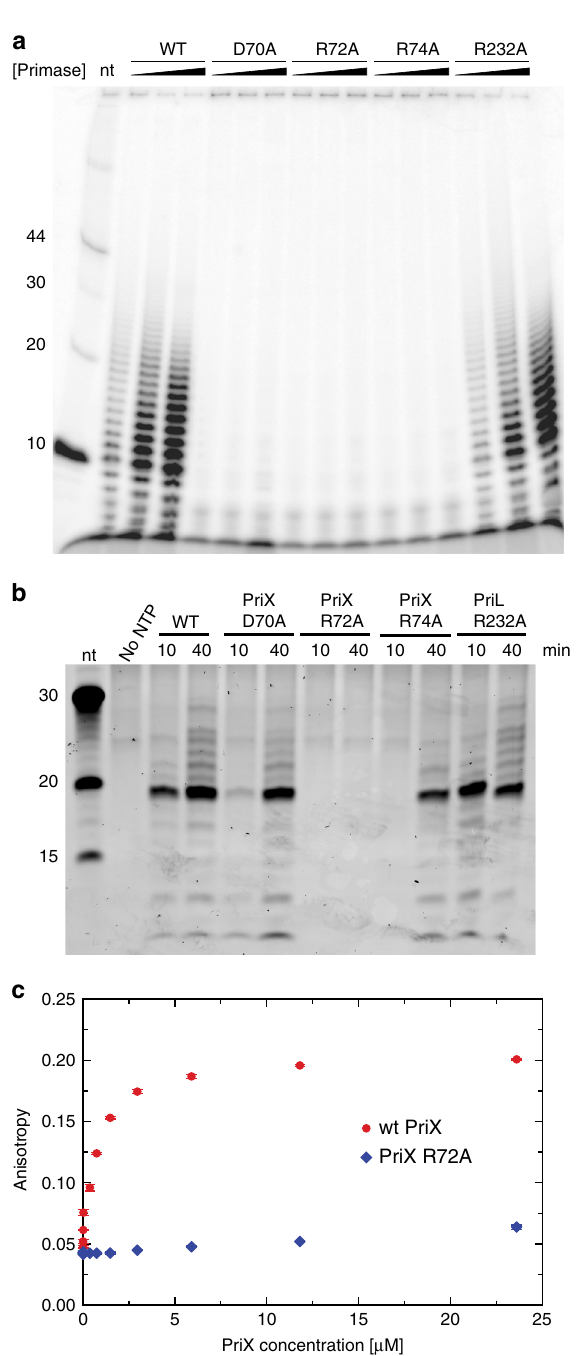
Fig. 3 PriX NTP-binding residues are necessary for RNA primer synthesis. a Primer synthesis assay on poly(dT) ssDNA for increasing concentrations (125 nM, 250 nM and 500 nM) of wild-type and mutant PriSLX. The reaction products were separated by PAGE under denaturing conditions and detected by phosphorimaging of the incorporated 32 P- α ATP. b Primer synthesis assay on mixed-sequence ssDNA 100mer with fi xed concentration of wild-type and mutant primase, at 10 ′ and 40 ′ time points. The reaction products were separated by denaturing PAGE, stained with SYBR Gold and detected by phosphorimaging. c ATP binding by wild-type and R72A PriX. Binding was measured by fl uorescence polarization of fl uorescein-labeled ATP in the presence of increasing amounts of